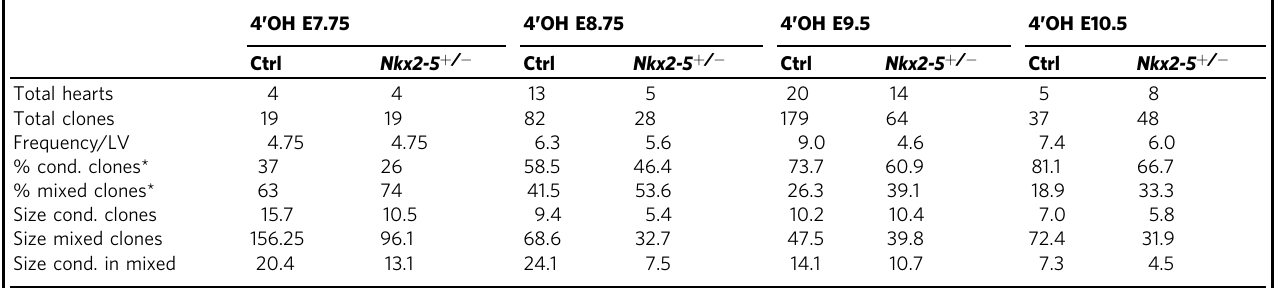
Table represents the n values of hearts and clones analyzed in this study, using Sma-CreERT2 :: R26R-Confetti mouse line. Asterisks shows percentages of conductive clones versus mixed clones. Non- conductive clones are excluded from the